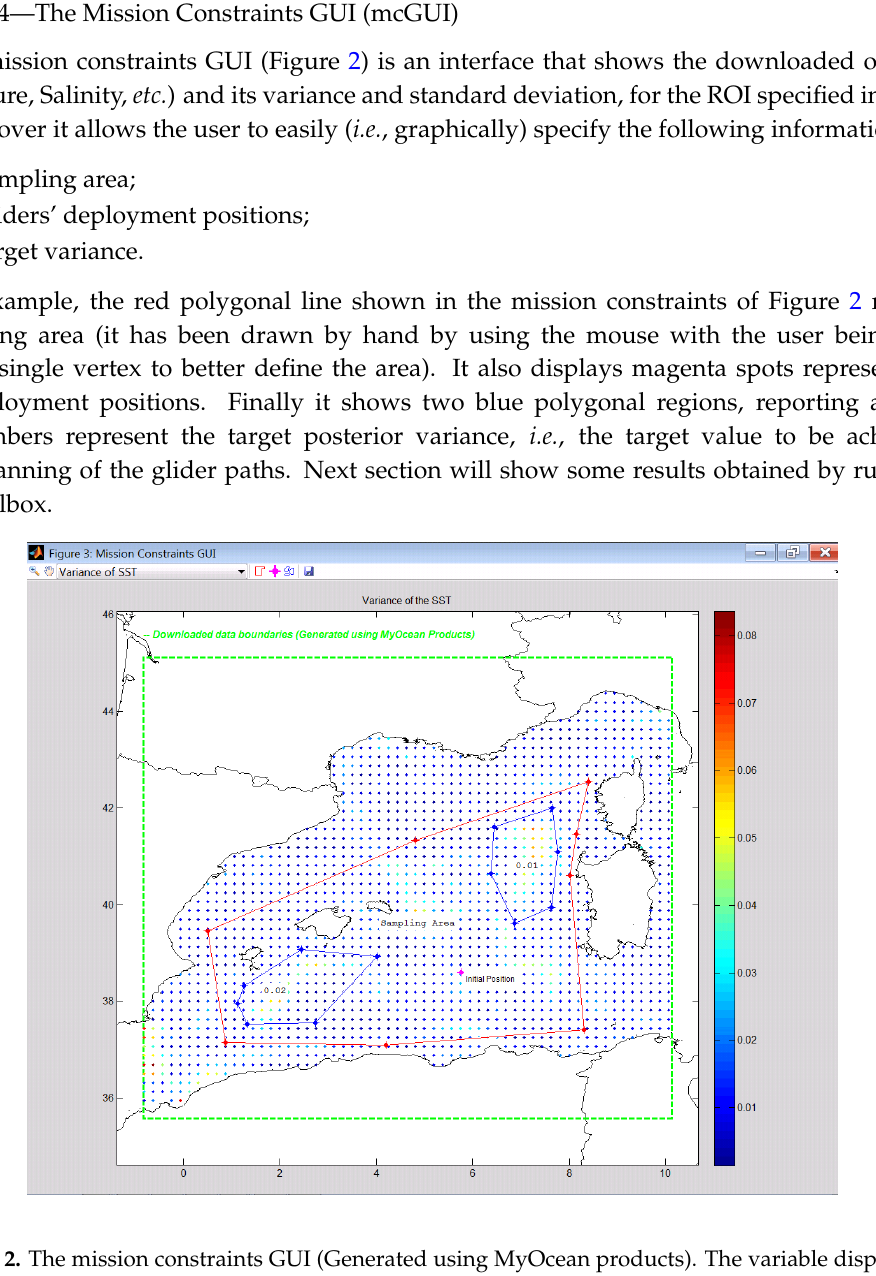
Figure 2. The mission constraints GUI (Generated using MyOcean products). The variable displayed is the variance of the Sea Surface Temperature (the colormap on the right shows its range of variability). In the sampling area delimited by a red polygon, the initial deployment position of one glider is indicated by a magenta spot. The two regions delimited by blue polygons area areas in which a target variance has been defined by the user (in the first, on the left, the target value is 0.02, while in the second, on the right, the target is